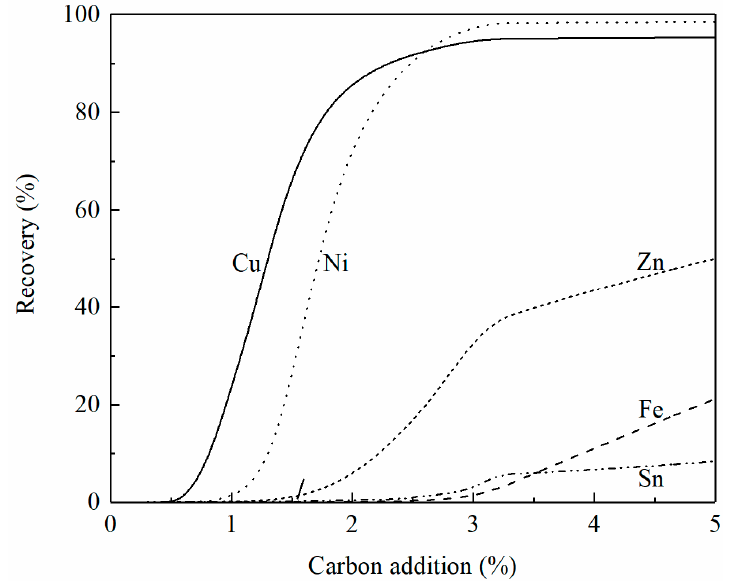
Figure 9. Effect of carbon addition on the recovery of copper, iron, zinc, nickel, and tin in converting slag at 1250 ° C, calculated by FactSage 8.2.